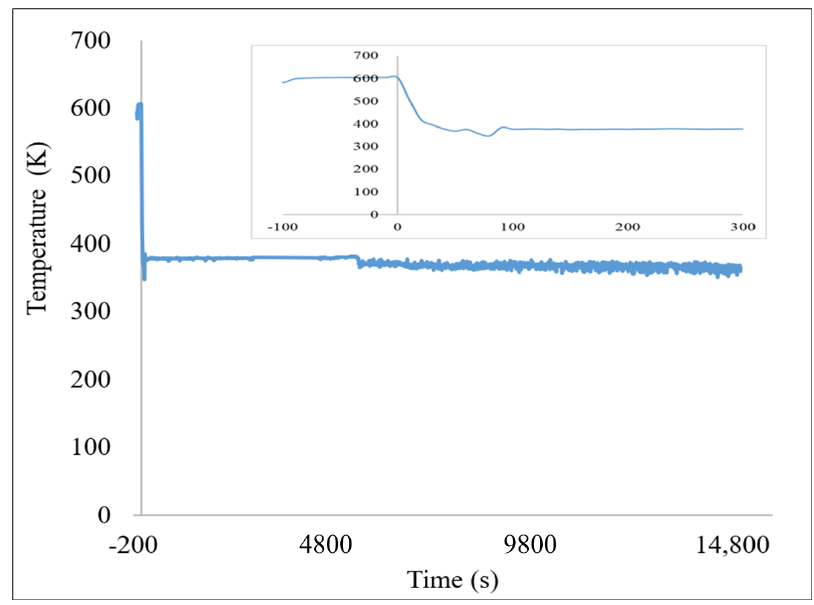
Figure 11. Central fuel temperature.